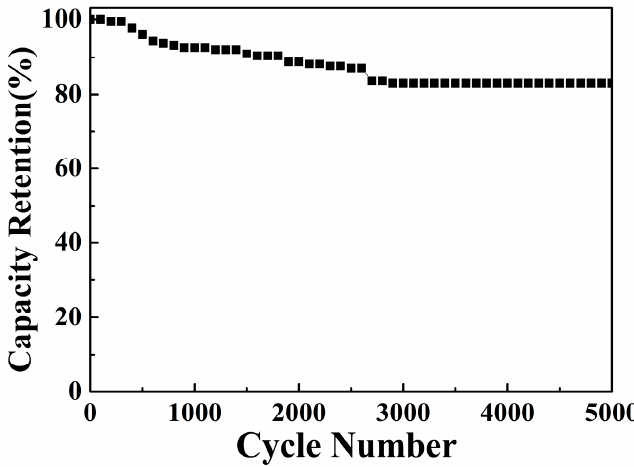
Figure 12. Cyclic stability of the CuO/NCS electrode.